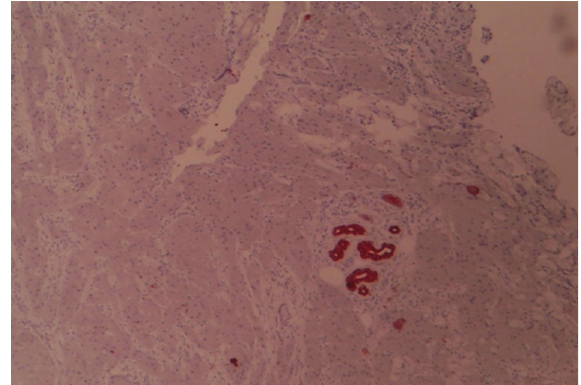
Figure 5: The lack of GCDFP-15 immunostaining in tumor cells ( ×